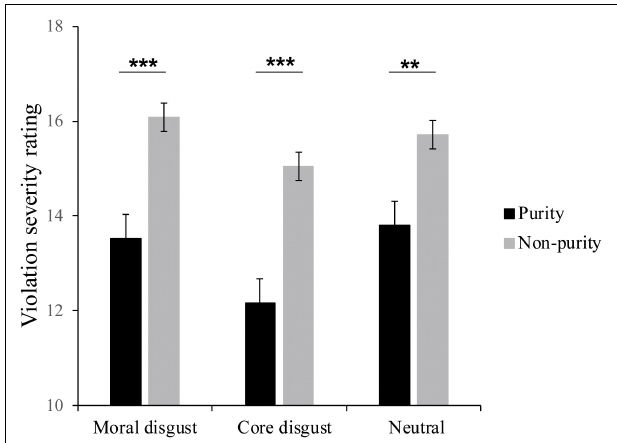
FIGURE 2 | The violation severity ratings of behavior response for each condition in moral disgust, core disgust, and neutral groups; the means and standard errors are shown, * p < 0.05, ** p < 0.01, *** p <